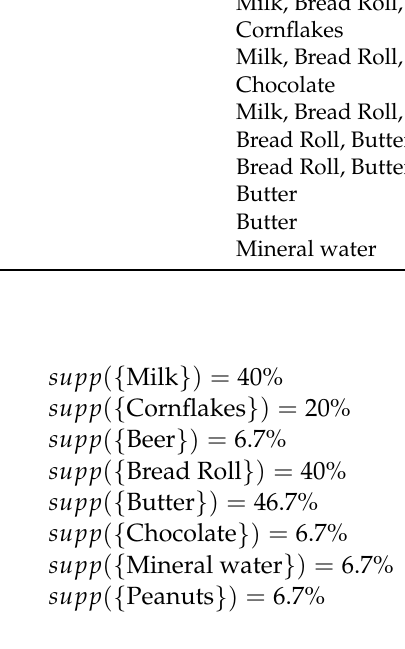
Table 1. Set of 15 transactions.